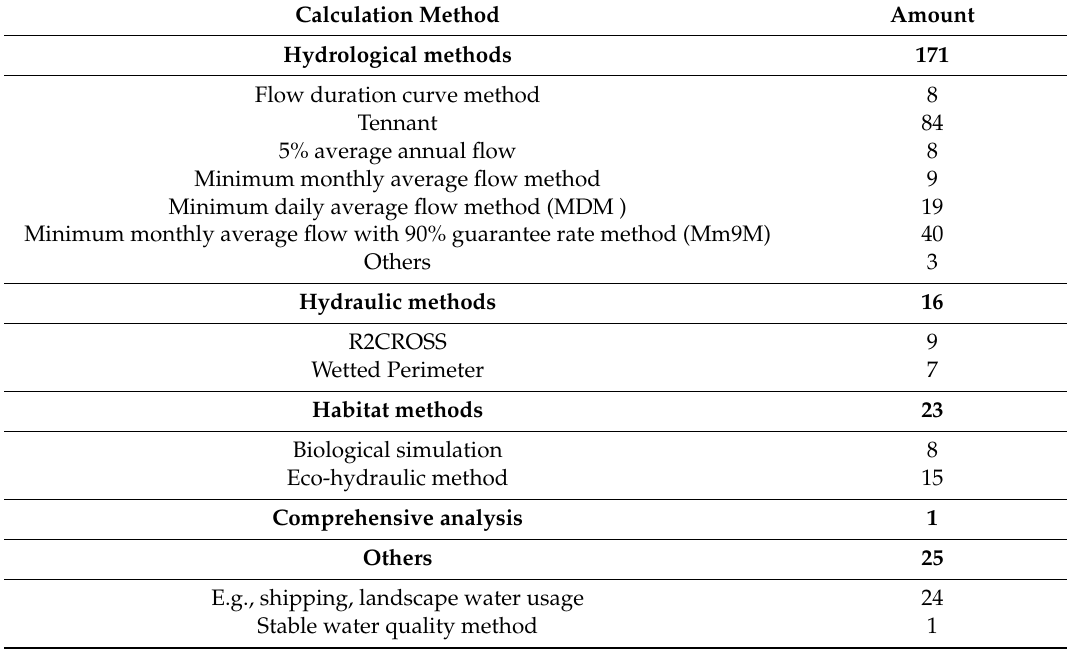
Table 2. Application of e-flow methods for water storage and hydropower projects since